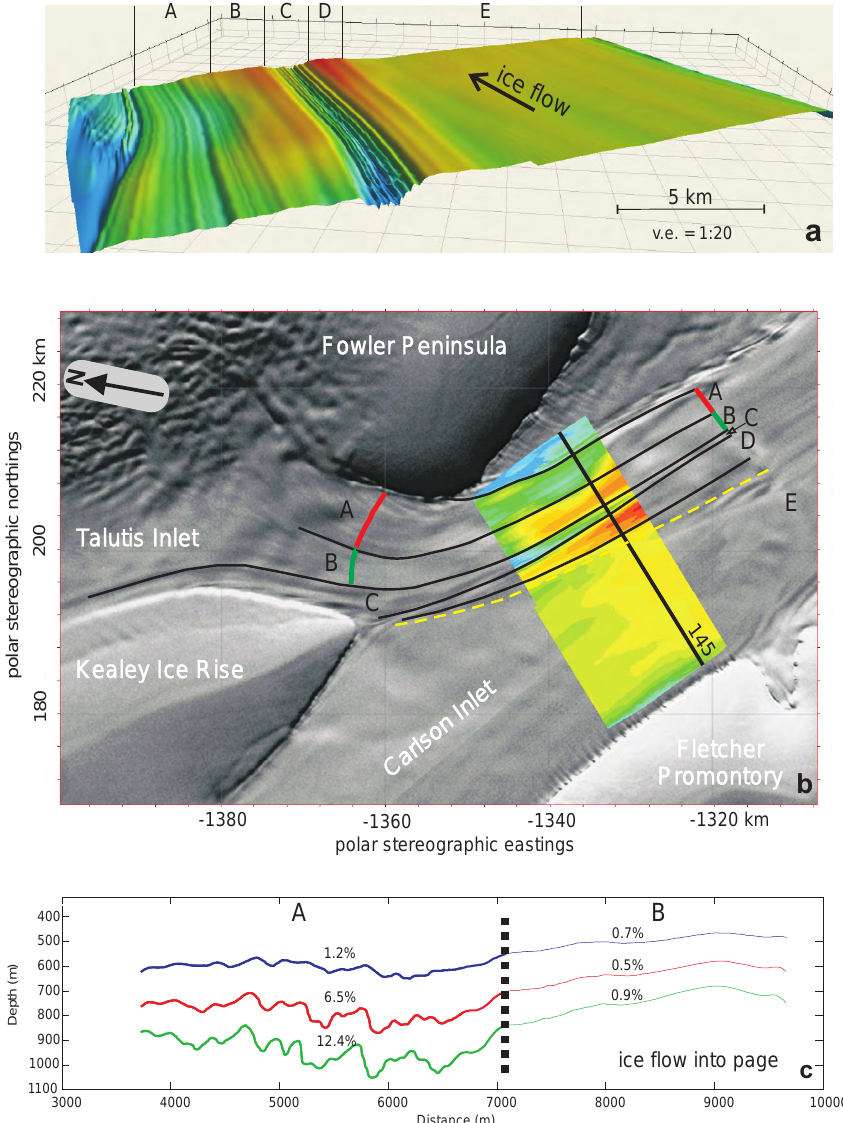
Fig. 4. (a) Three-dimensional view of one isochrone from a depth of approximately 200m derived from interpretation of a grid of lines each spaced 500m apart covering the box shown in Fig. 1. Ice flow is away from the observer and the vertical range of the surface is 60m. (b) Map view of the confluence of Talutis Ice Stream and Carlson Inlet with the 200m isochrone shown as a colour contour plot superimposed on a MOA surface image. Zone A represents Talutis Ice Stream ice derived from the western flank of Fowler Peninsula that has experienced lateral compression during downstream flow. Zone B is ice that has flowed down the centre of Talutis Inlet with little lateral compression. Zone C is the shear margin generated as Talutis Ice Stream enters Carlson Inlet. Zone D is Carlson Inlet ice up warped by lateral compression from the inflow of Talutis Ice Stream into Carlson Inlet, this ice is entrained into the fast flow. Zone E is the region of Carlson Inlet that has undergone no lateral compression and is slow-flowing. (c) Line drawing of isochrones in zones A and B. Figures above each horizon indicate the percentage of horizontal shortening experienced by that section. Both zones A and B are fast flowing but zone A has undergone a higher degree of convergence compared to zone